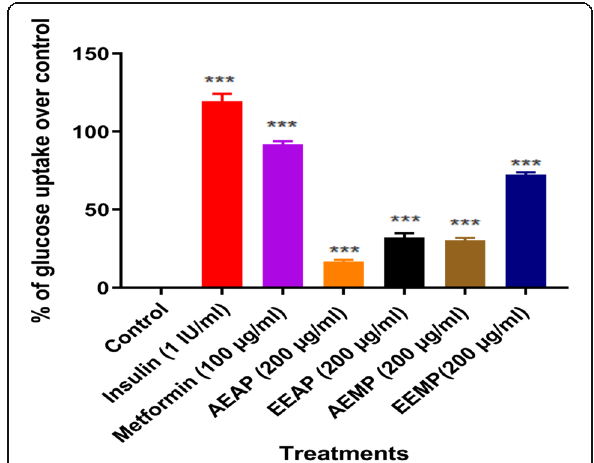
Fig. 4 Glucose uptake activity of extracts on the L-6 cell line. Values